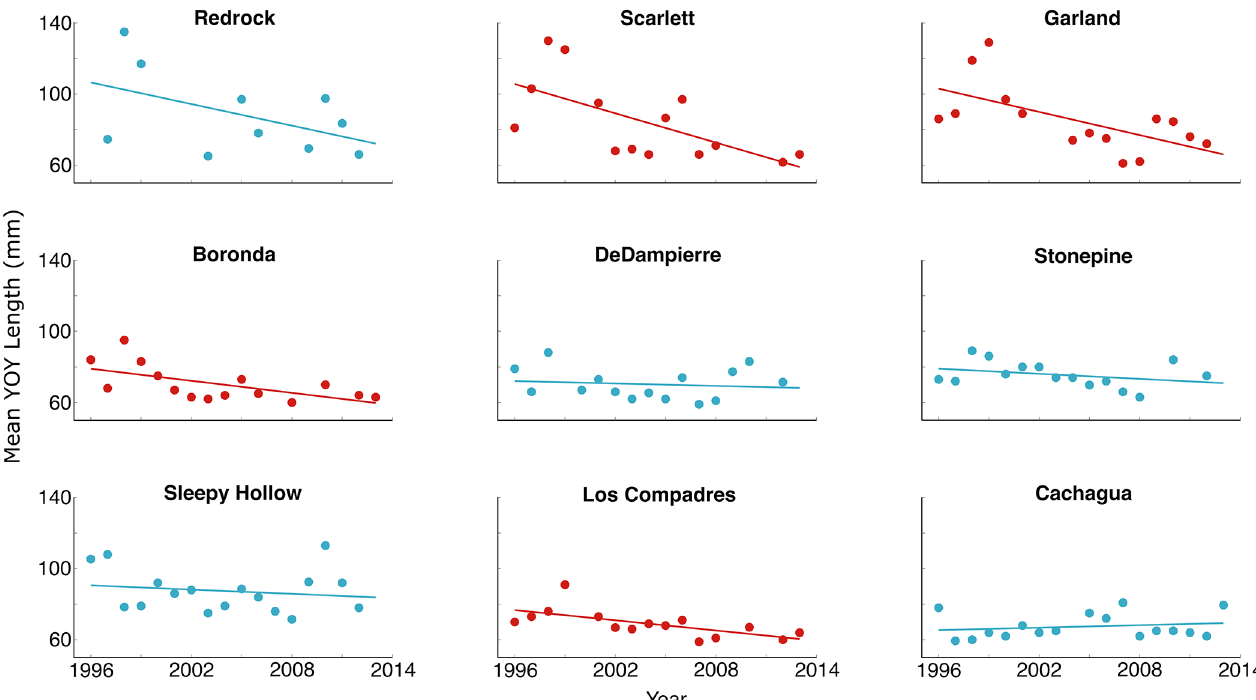
Fig 4. Mean lengths of YOY O . mykiss at October survey sites, 1996–2013. Sites are orderedhorizontallyfrom further downstream(Redrock) to furthest upstream (Cachagua). Significantregression slopes are in red; names of sites as in Fig 2.